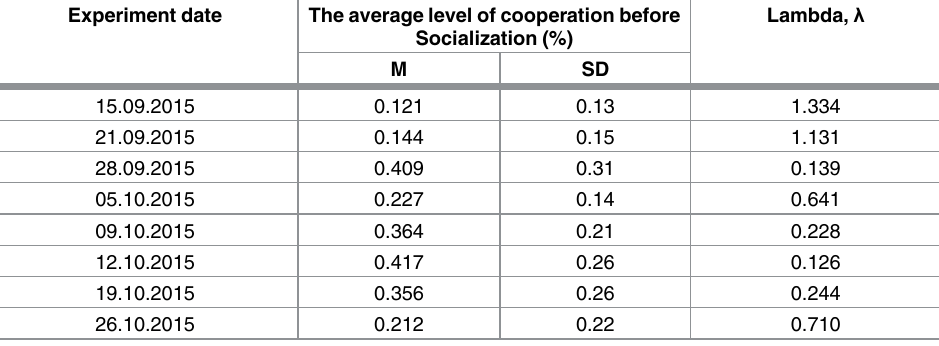
Table 2. The average level of cooperation and the QRE parameter for all the experiments in PD before the Socialization stage.